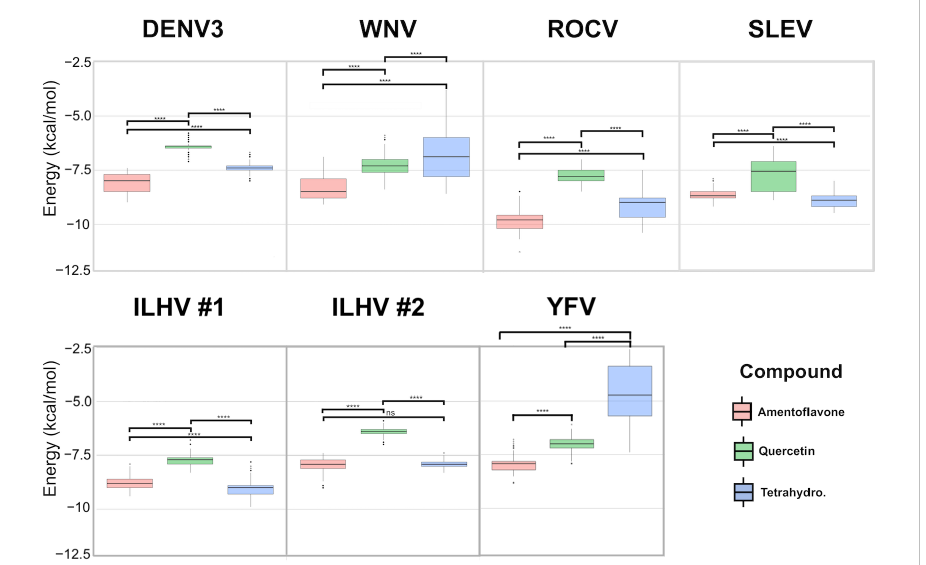
Figure 4. Box plot of the energy distributions of each ligand in dengue virus (DENV), West Nile virus (WNV), Rocio virus (ROCV), Saint Louis encephalitis virus (SLEV), Ilhéus virus (ILHV), and yellow fever virus (YFV). **** p < 0.0001; ns: